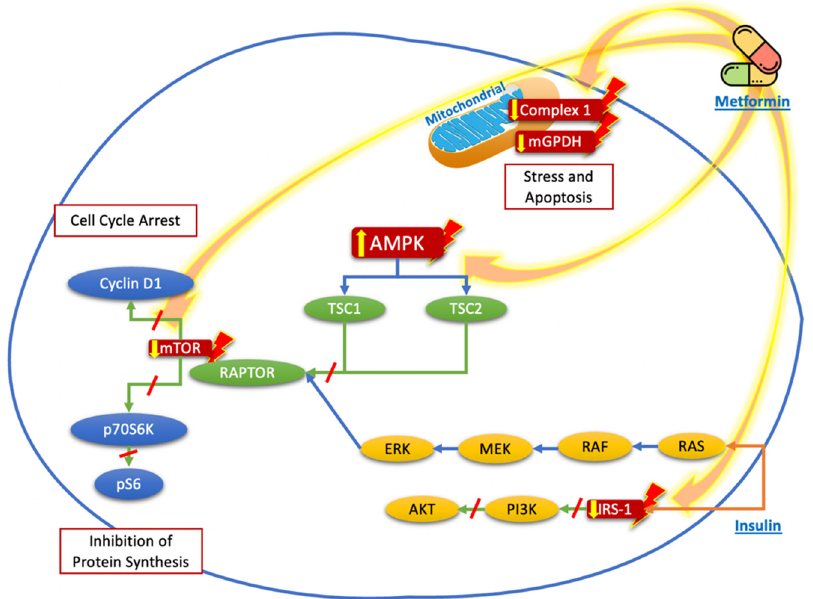
Figure 1. Proposed targets of the molecular mechanisms of metformin to reduce the proliferation and growth of thyroid cancer cells. Metformin acts mainly through nuclear stimulation of AMPK, which decreases the activation of TSC2 and the activation of mTOR, with the subsequent reduction in cyclin D1 and p70S6K/pS6 signaling, resulting in the inhibition of protein synthesis and cell cycle arrest. The blockade of IRS-1 phosphorylation decreases the signaling of the PI3K/AKT pathway, which also contributes to the reduction in mTOR pathway activation. Likewise, the direct effects of metformin on the mitochondria, by reducing Complex 1 or mGPDH, decreases energy production and cell stress and leads to cell apoptosis.